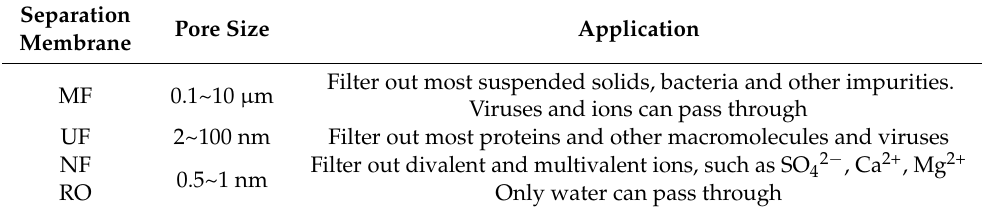
Table 1. The classification of membrane separation technology. Separation Pore Size Application Membrane Filter out most suspended solids, bacteria and other impurities. MF 0.1~10 µ m Viruses and ions can pass